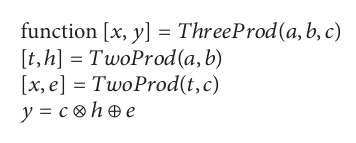
Algorithm 4: Product of three floating point